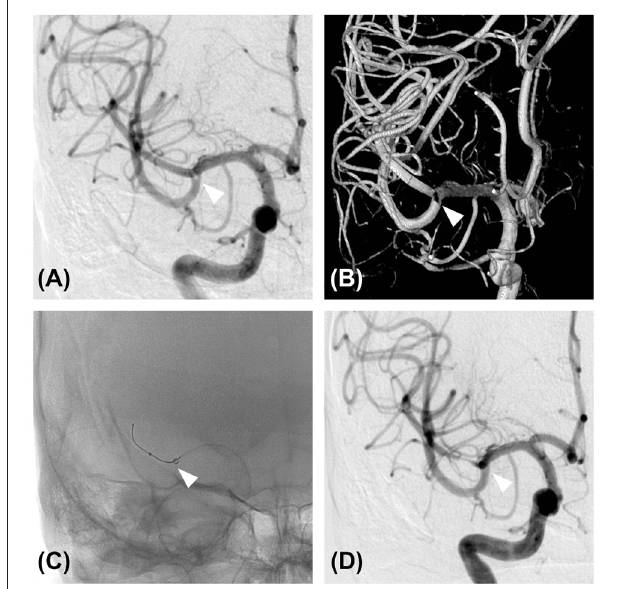
FIGURE 2 | Diagnostic angiography and mechanical thrombectomy. (A) Cerebral angiography of the right internal carotid artery showing an M1 subocclusive thrombus (white arrowhead). (B) Three-dimensional reconstruction of the cerebral angiography of the right internal carotid artery also showed the presence of a thrombus (white arrowhead). (C) Mechanical thrombectomy was performed using a direct aspiration first-pass technique. An aspiration catheter was advanced to the location of the thrombus (white arrowhead) with the aid of a microcatheter and a micro guidewire. (D) Cerebral angiography of the right internal carotid artery after the first pass. Note the complete removal of the thrombus (white